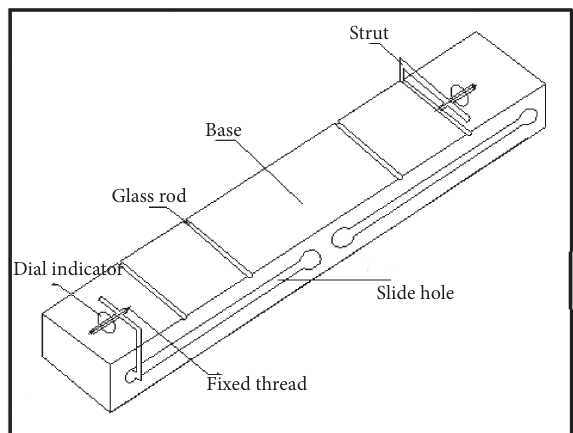
Figure 1: The self-designed platform.